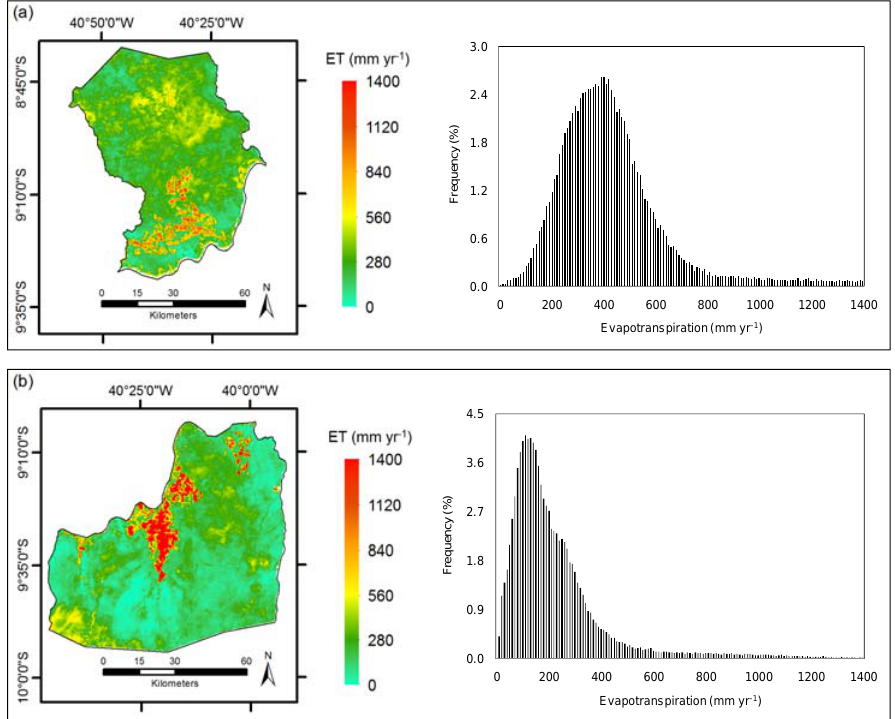
Figure 4. Annual values and histograms for actual evapotranspiration (ET) in the Brazilian semi-arid agricultural growing regions: ( a ) Petrolina Municipality, Pernambuco (PE) State; ( b ) Juazeiro Municipality, Bahia (BA)